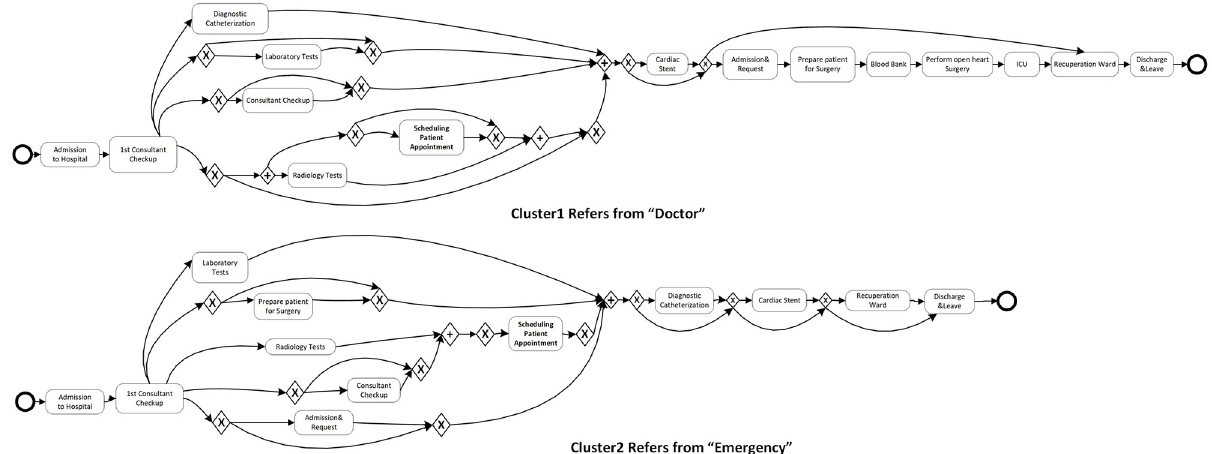
Fig 9. BPMN models of the two clusters generated from using Markov clustering algorithm upon on refers from attribute. (a) Cluster refers from “Doctor” (b) Cluster refers from “Emergency”.